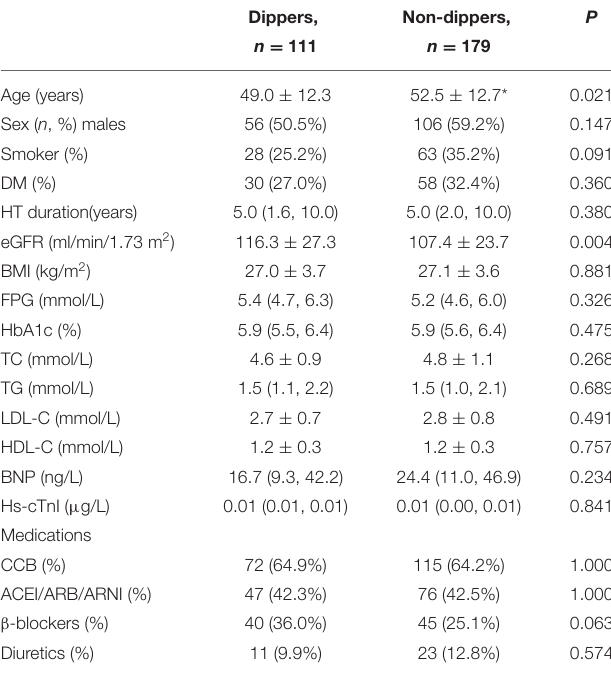
TABLE 1 | Clinical statistics of the study